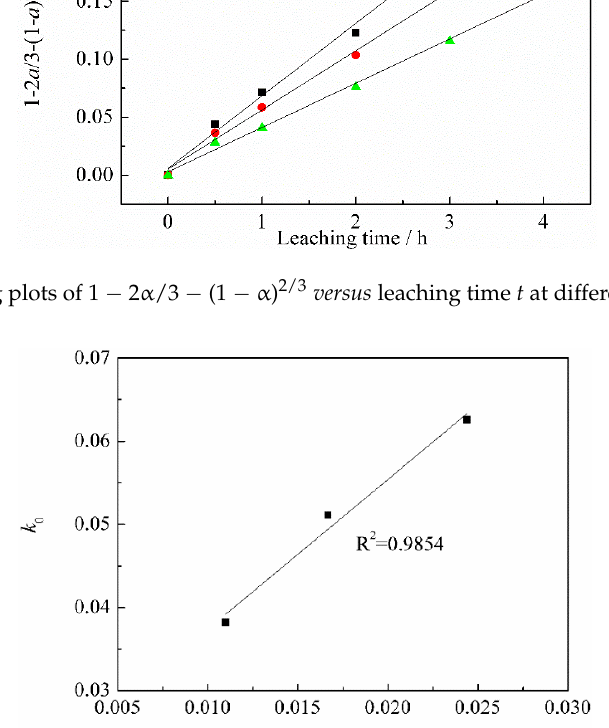
Figure 14. Fitting plot of k 0 as a function of d − 1 .